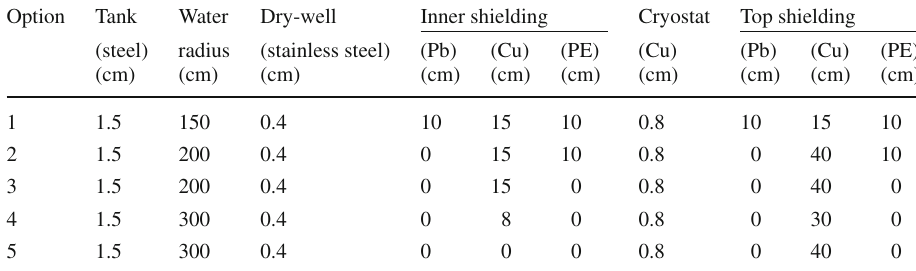
options for our shielding configuration,